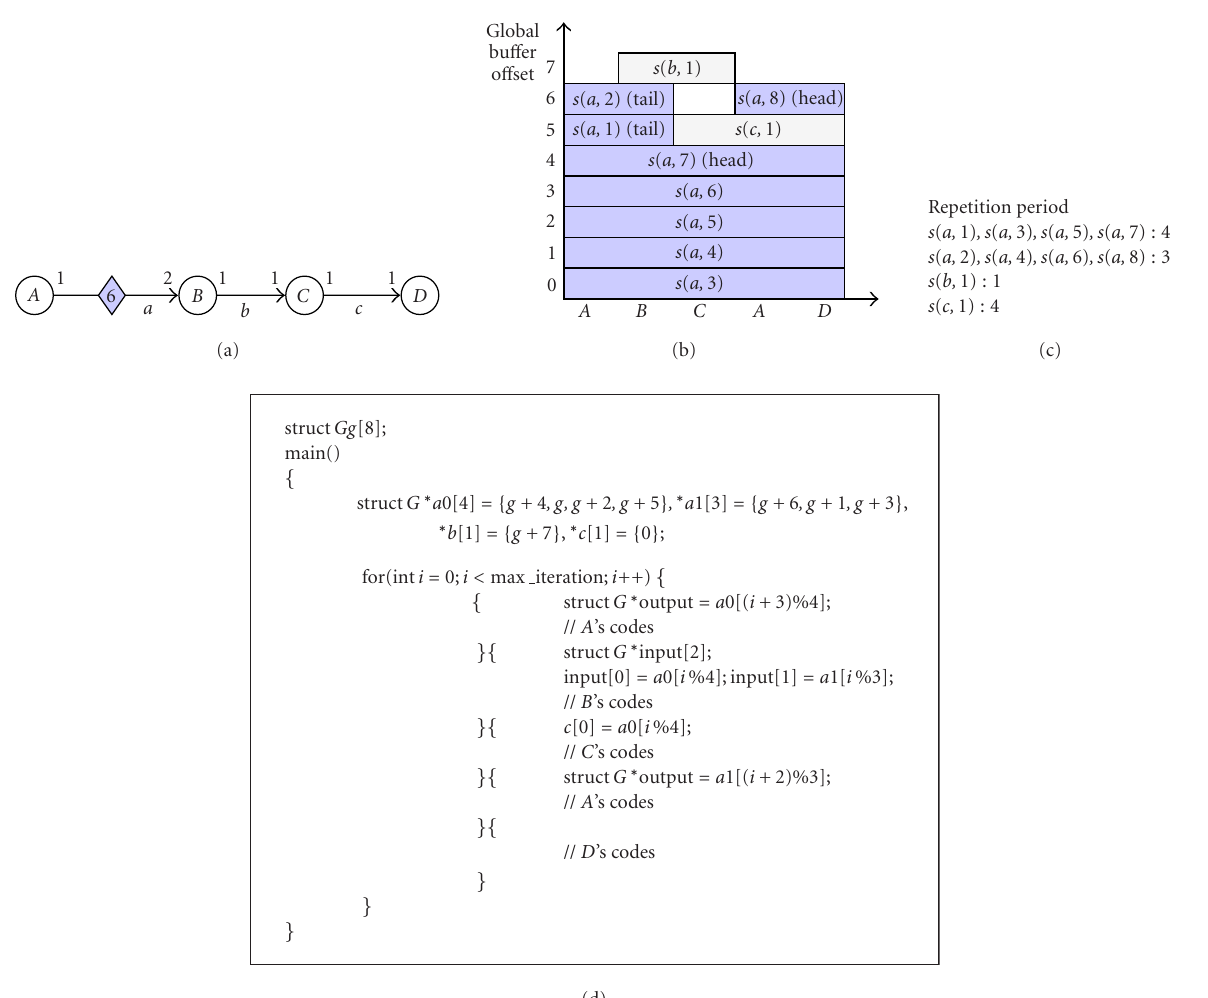
Figure 12: (a) An SDF graph with large initial samples, (b) an optimal global bu ff er lifetime chart, (c) repetition periods of sample lifetime patterns, and (d) generated code with dynamic binding after dividing local bu ff ers on arc AB into two local bu ff er